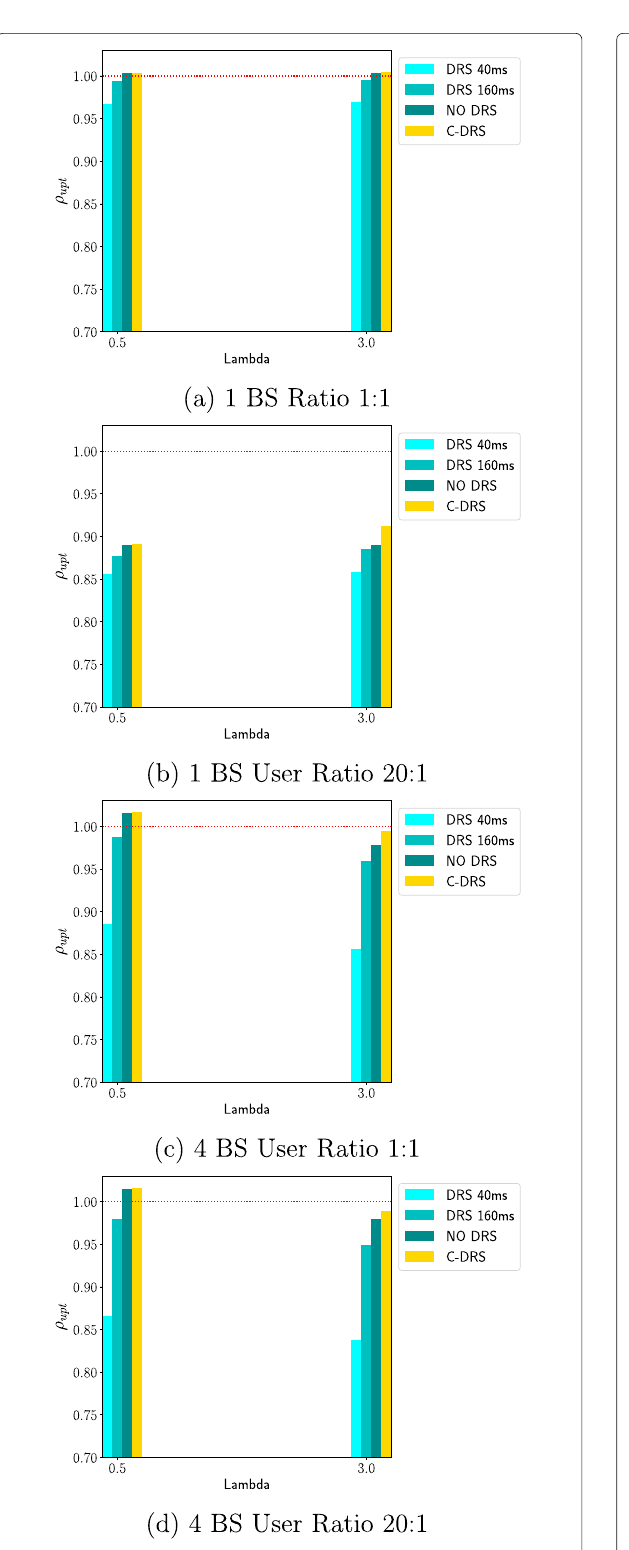
Fig. 13 Scenario density UPT fairness results (ped. mobility) Fig. 14 Static scenario density delay fairness